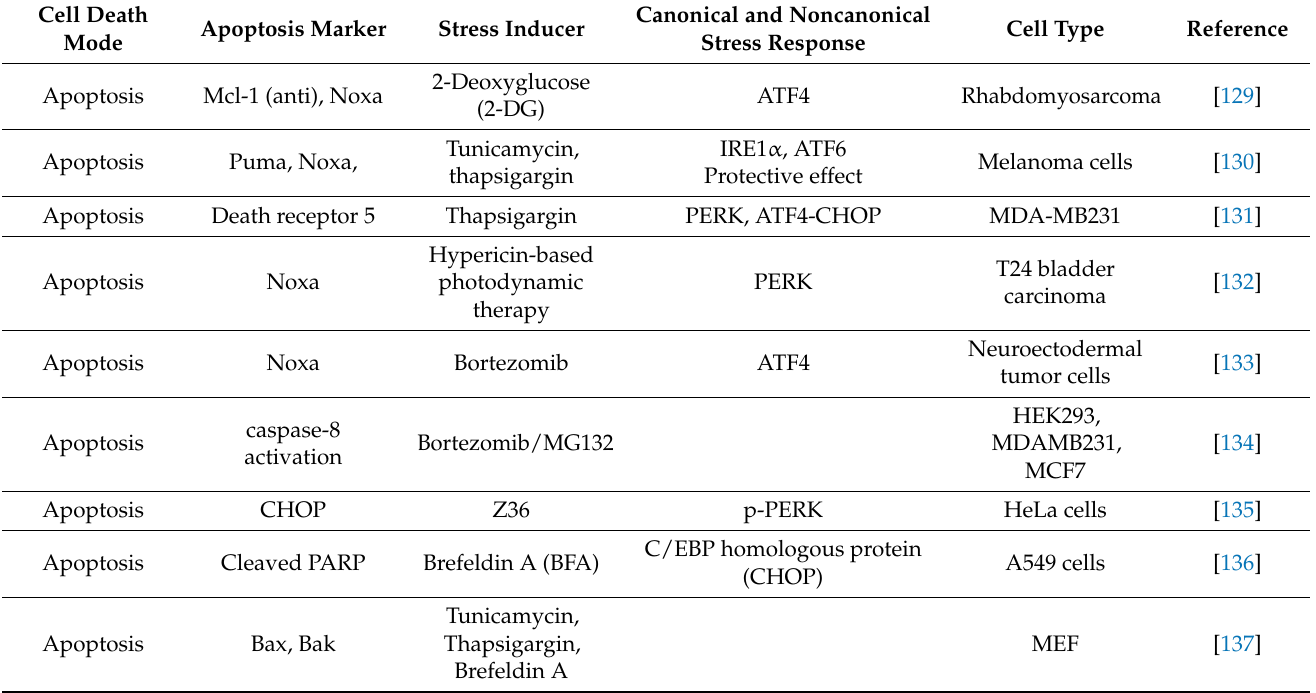
Table 1. Apoptotic marker proteins and stress inducers in canonical and noncanonical ER stress responses in different cell